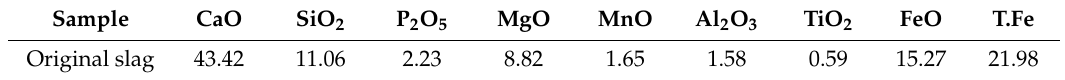
Table 1. Chemical composition of the original BOF